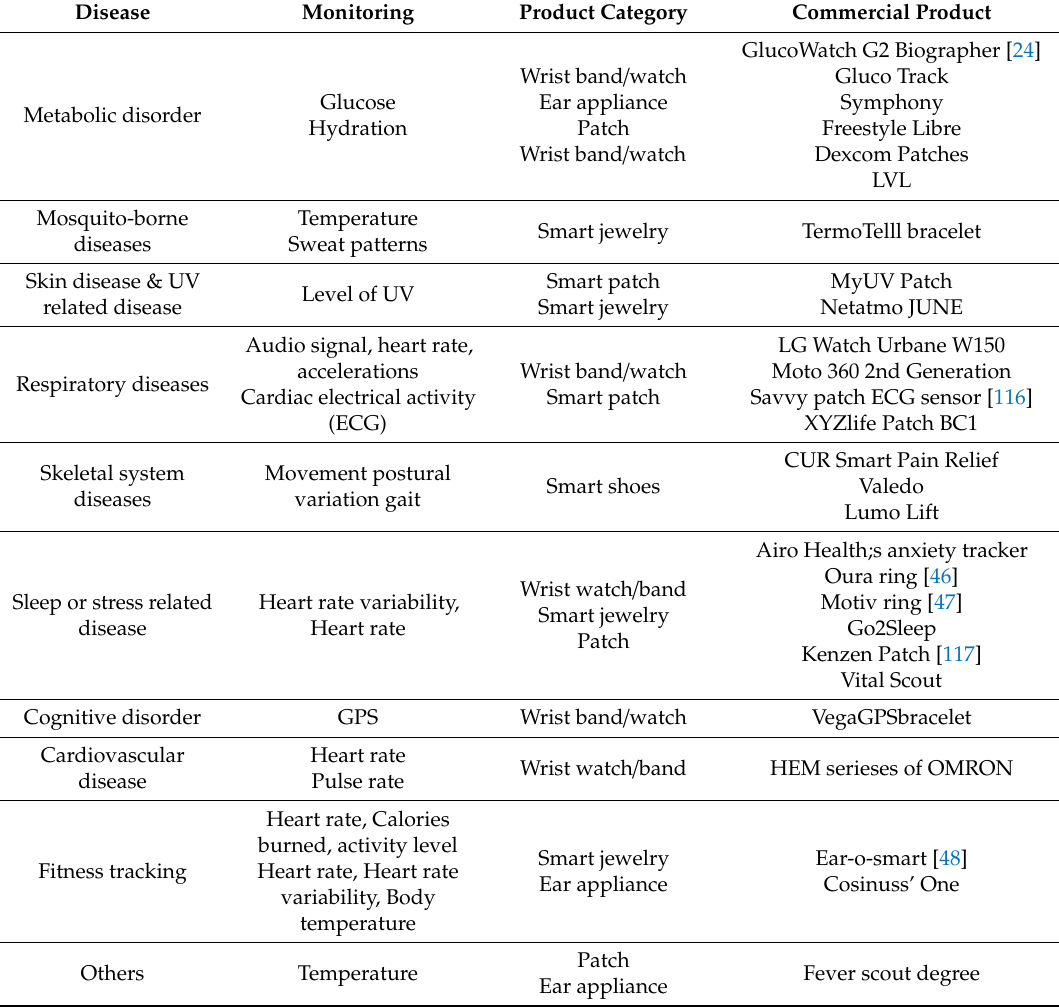
Table 4. Application of disease and examples of commercial wearable